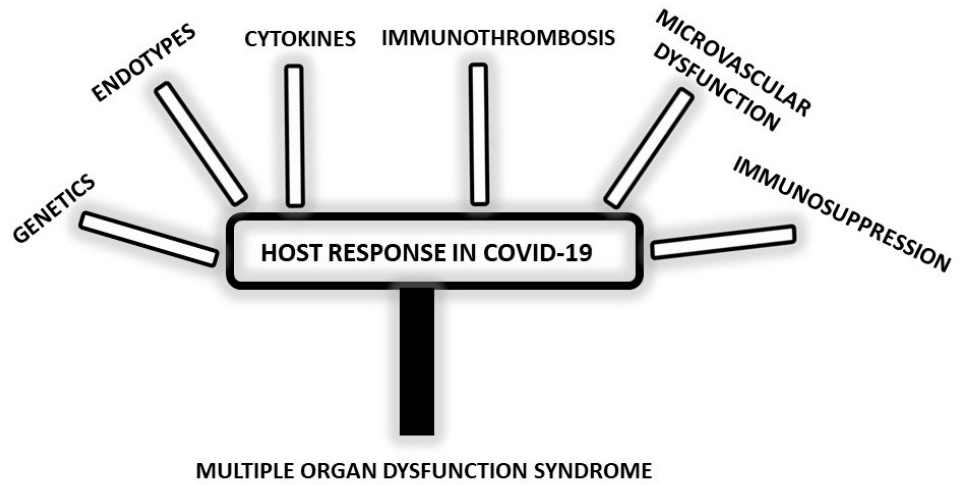
Figure 1. Key elements of host response in COVID-19.